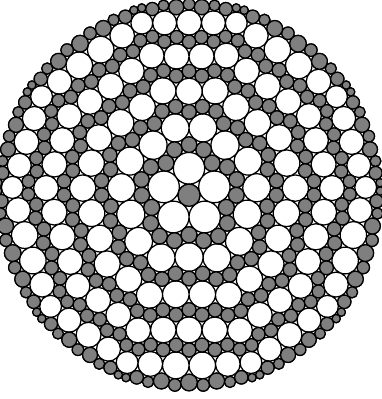
Figure 5.3. A portion of the layered packing generated by the sequence { 5,8,5,8, ... } . The circles of degree 5 are